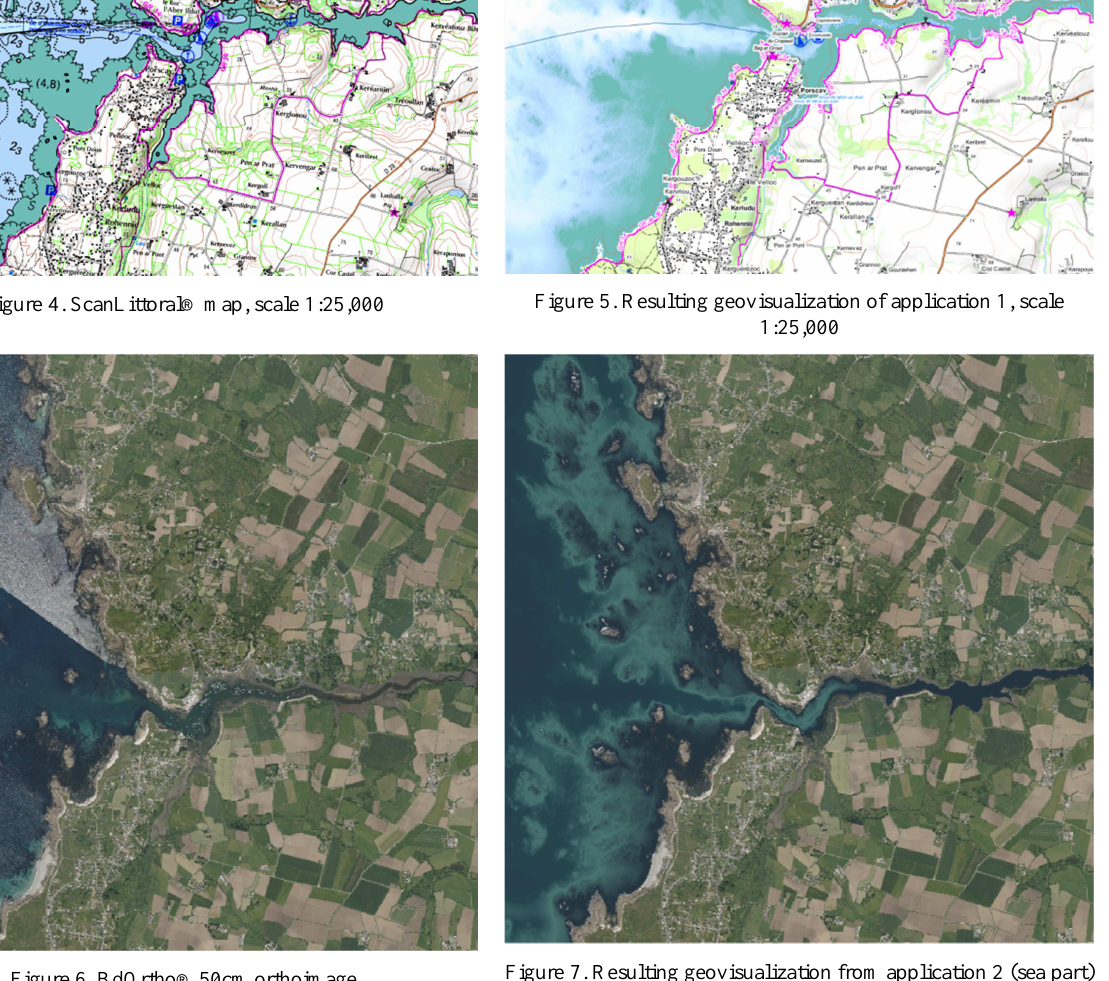
Figure 6. BdOrtho® 50cm orthoimage Figure 7. Resulting geovisualization from application 2 (sea part) and BdOrtho® 50cm (land part)